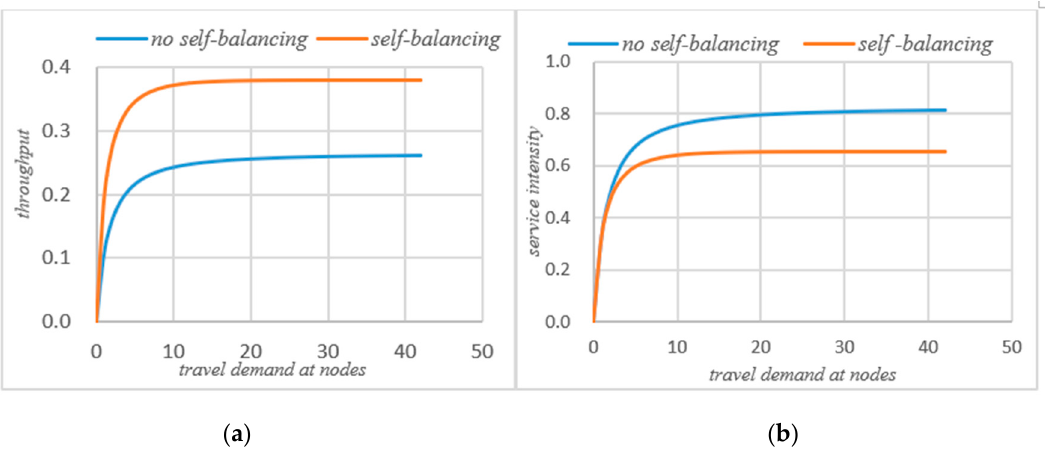
Figure 8. ( a )System throughput comparison; ( b ) system service intensity comparison. Figure 8. ( a ) System throughput comparison; ( b ) system service intensity